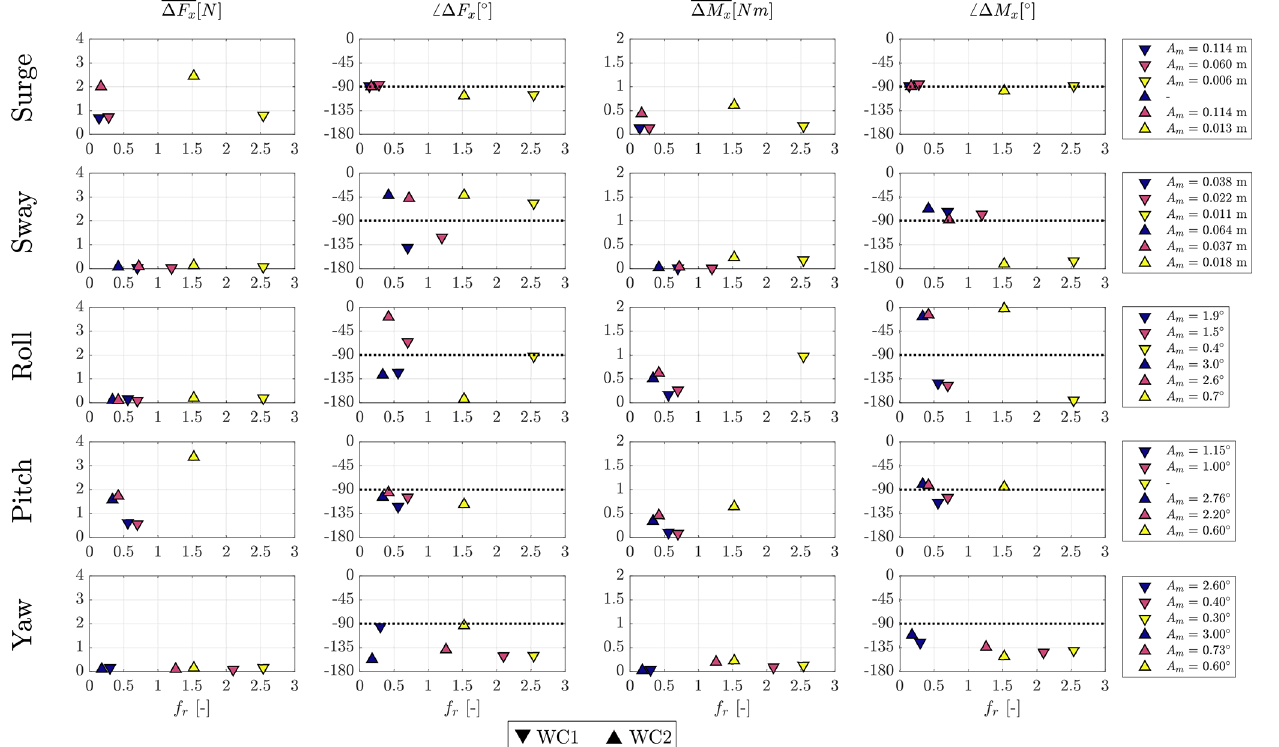
Figure 5. Amplitude and phase shift of the dynamic thrust force ( (cid:49)F x , (cid:54) (cid:49)F x ) and amplitude and phase shift of the dynamic torque ( (cid:49)M x , (cid:54) (cid:49)M x ) as a function of reduced frequency f r . Reversed-triangle markers correspond to results for the wind condition 1 (WC1), triangle markers correspond to results for wind condition 2 (WC2), and colors identify different values of the motion amplitude A m